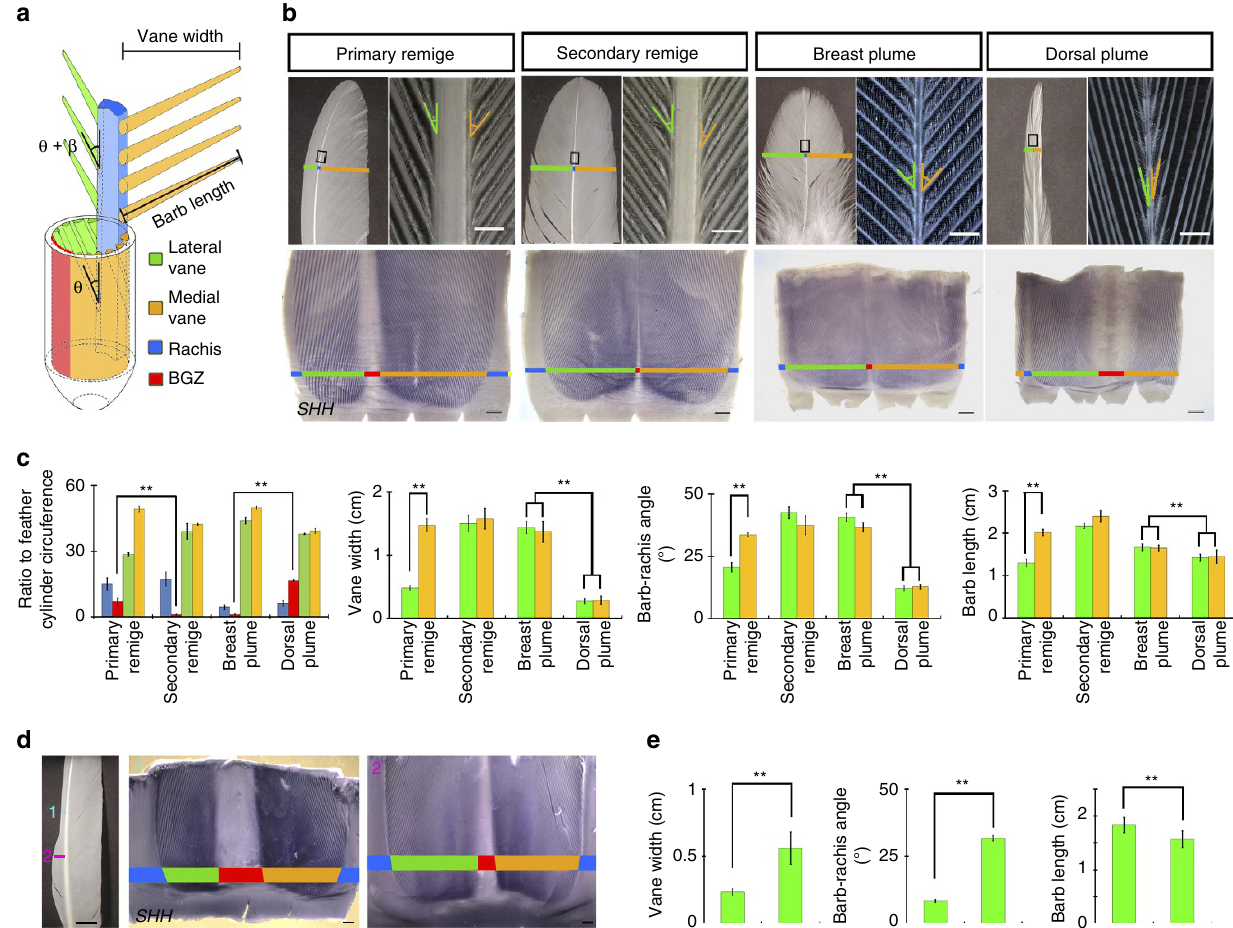
Figure 1 | Feather vane shapes vary with differential BGZ topology and barb-rachis angles. ( a ) Schematic drawing of feather before and after maturation. The barb-rachis angle is a combination of the helical growth angle ( y ) during branching morphogenesis and the expansion angle ( b ) after maturation. ( b ) Comparing morphologies of two types of chicken remiges with different asymmetry levels and two types of body plumes with different vane widths before and after maturation. Feather epithelial cylinder (before maturation) was cut open at the rachis side and SHH in situ hybridization was used to highlight vanes. Boxes indicate the regions magnified on the right. Vane widths and barb-rachis angles are highlighted by bars and angle symbols, respectively. Scale bars, 500 m m. ( c ) Quantification of the ratio of different feather epithelial regions before maturation ( n ¼ 4); vane widths, barb-rachis angles and barb lengths after maturation ( n ¼ 30). Error bars denote s.d. (cid:2)(cid:2) P o 0.01. ( d ) Emarginated primary remiges demonstrate abrupt change of vane width. Feathers growing to a point B 1cm distal to the emarginated notch position were collected and compared with those B 1cm proximal to the notch. A significant shrinkage of the BGZ was observed in those proximal to the notch. Scale bars, 500 m m. ( e ) Comparisons of vane widths ( n ¼ 10), barb-rachis angles ( n ¼ 16) and barb lengths ( n ¼ 16) at positions B 1cm distal and proximal to the notch in mature feathers. Error bars denote s.d. (cid:2)(cid:2) P o